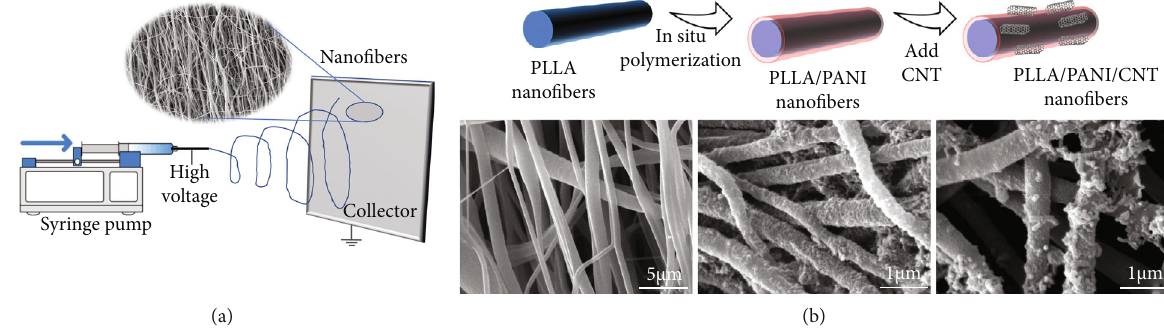
Figure 1: (a) Schematic representation of electrospinning process used to fabricate PLLA nano fi bers. (b) Surface of PLLA nano fi bers were modi fi ed using in situ polymerization technique to form PANI coating. Surface coating of PLLA nano fi bers with PANI was also tried in the presence of CNT. Scanning electron micrographs of PLLA, PLLA/PANI, and PLLA/PANI/CNT nano fi bers were